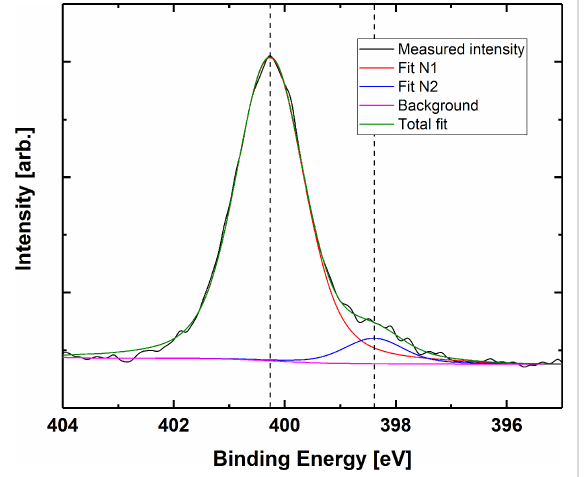
Figure 13: Nitrogen 1s peak for film based on thymine. The binding energy is corrected by calibrating towards adventitious carbon (284.8 eV).